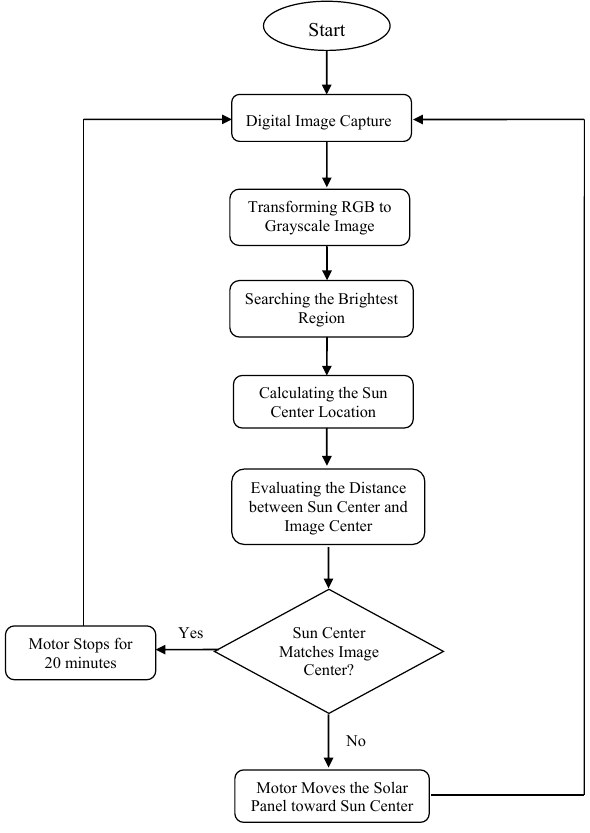
Figure 12. The operation flow of the solar tracking system.